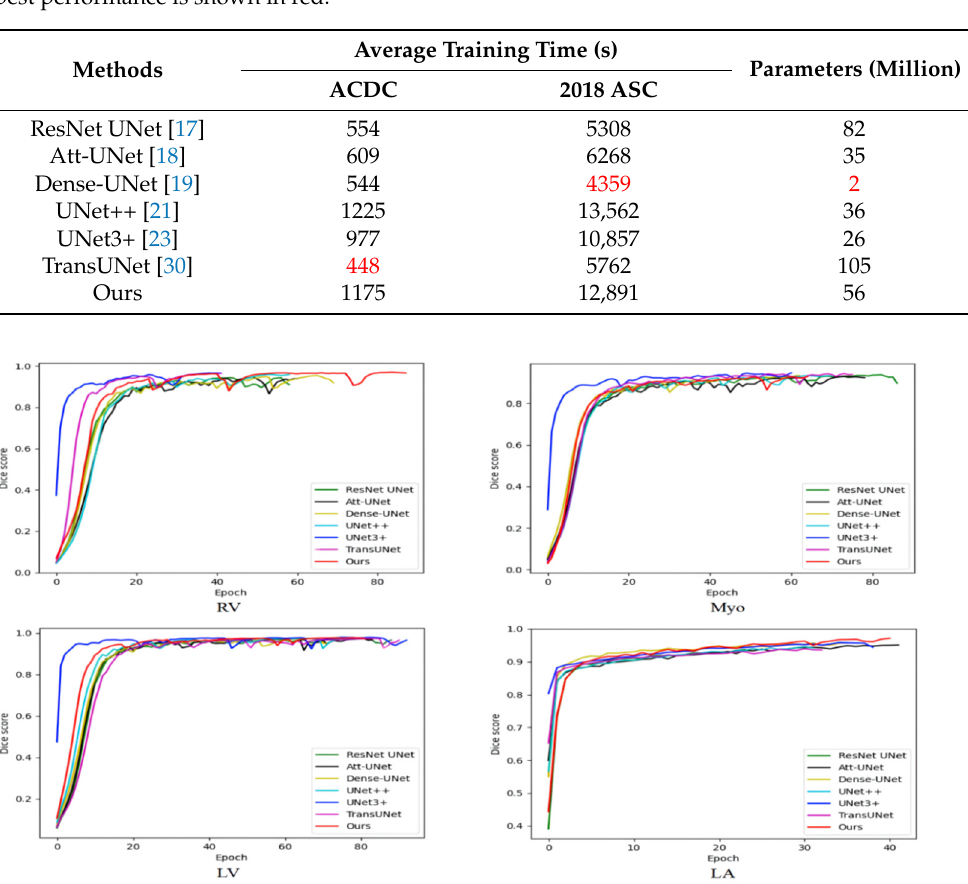
Figure 6. The variation of the training set dice score with iterations.